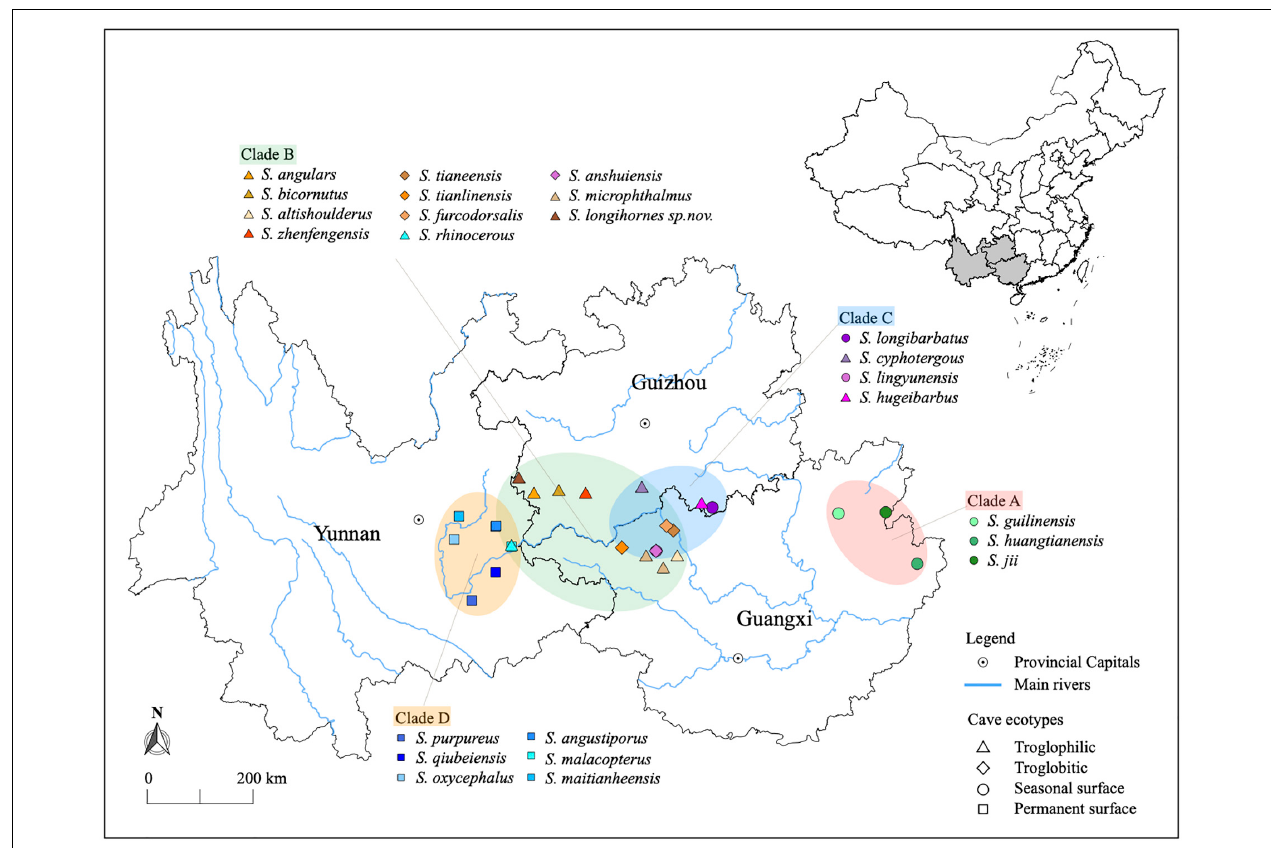
FIGURE 1 | Distribution of 24 Sinocyclocheilus species and geographic context of phylogenetic clades. Colored dots represent the species. The four phylogenetic clades are represented by the colored ellipses. Clades A (East) and D (West) are geographically disjunct and Clades B and C are